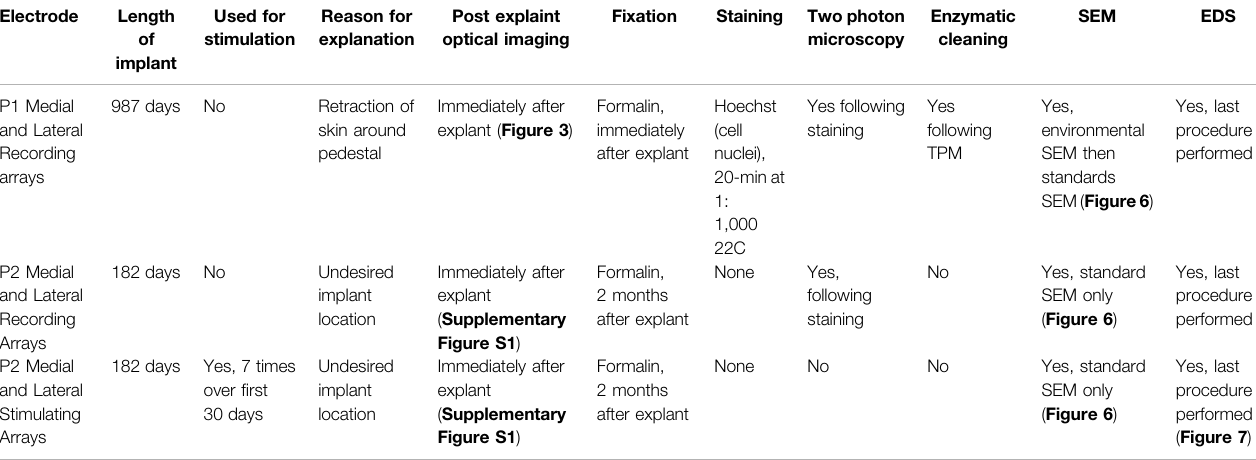
TABLE 1 | Timeline of implantation, procedures, and explant